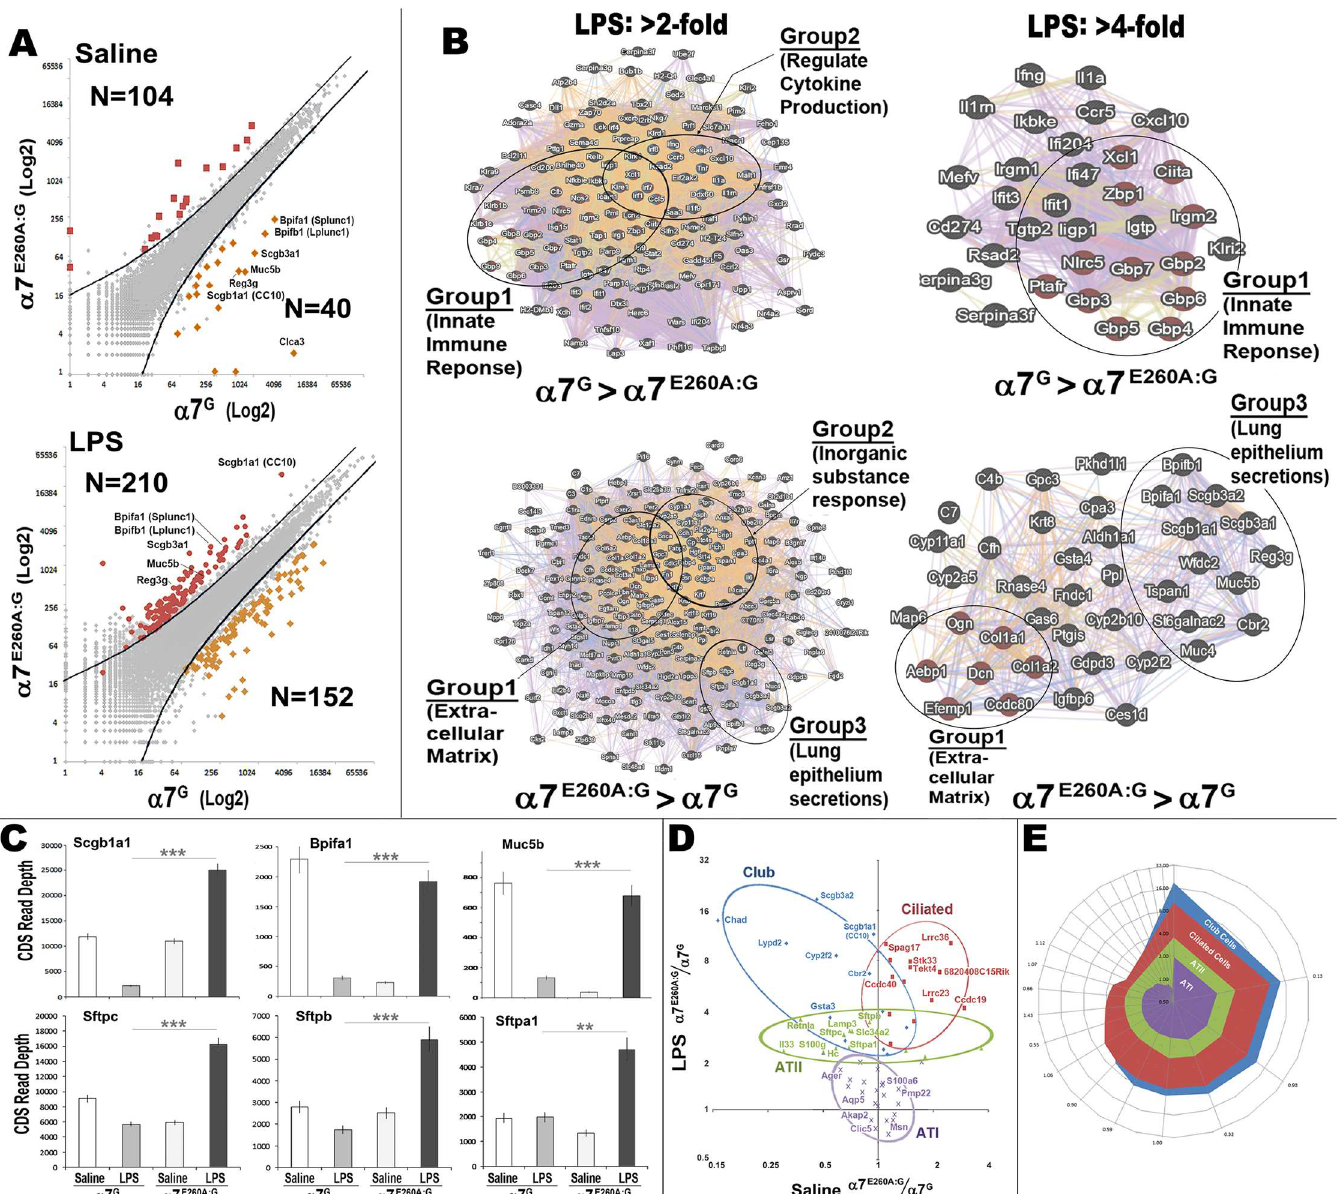
Fig 5. RNA-Seq results reveal α 7-impact on cell-specific changes in transcription following LPS challenge. A) CD45 - interstitial cells were isolated and RNA-Seqperformed. Transcript data were converted to CDS values and these were then comparedas labeledbetween α 7-genotypes following challenge with i.n. saline or i.n. LPS as indicated.The lines indicate a 2-fold threshold difference in expressionbetweengenotypes and the number (N) of genetranscripts exceedingthe 200 averageread depth minimalcut-off (see S1 Table). Genes achievinga 4-fold or greater are colored, and some of